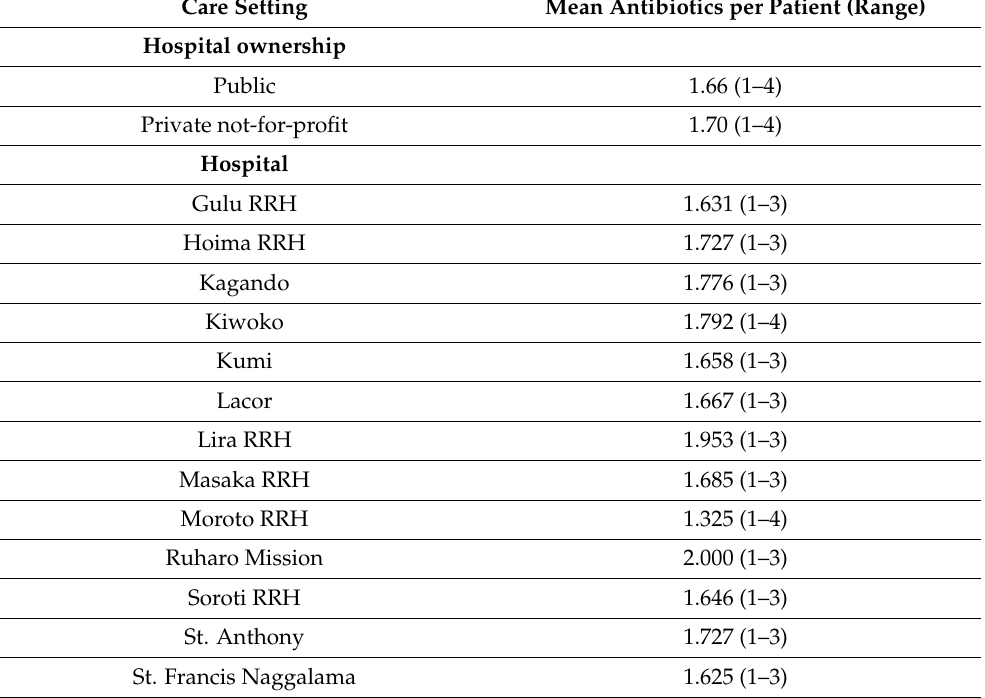
Table 4. Antibiotic use by hospital.